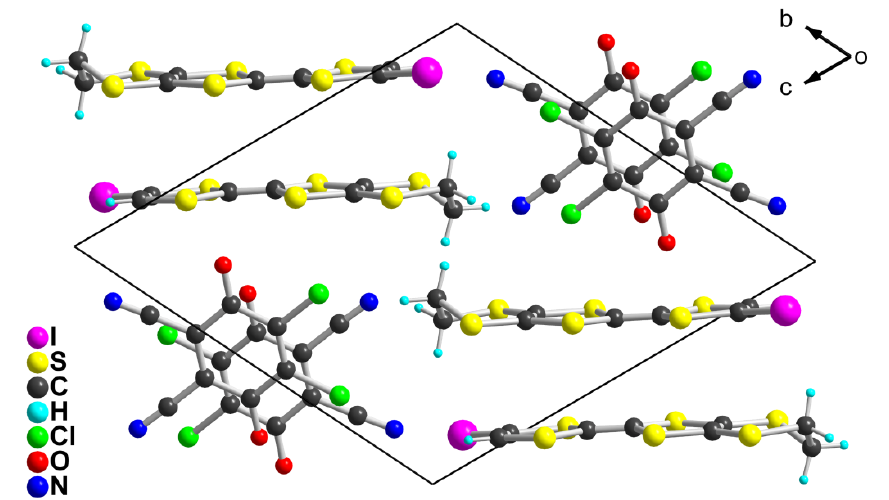
Figure 1. Projection view (along a ) of the unit cell of ( 1